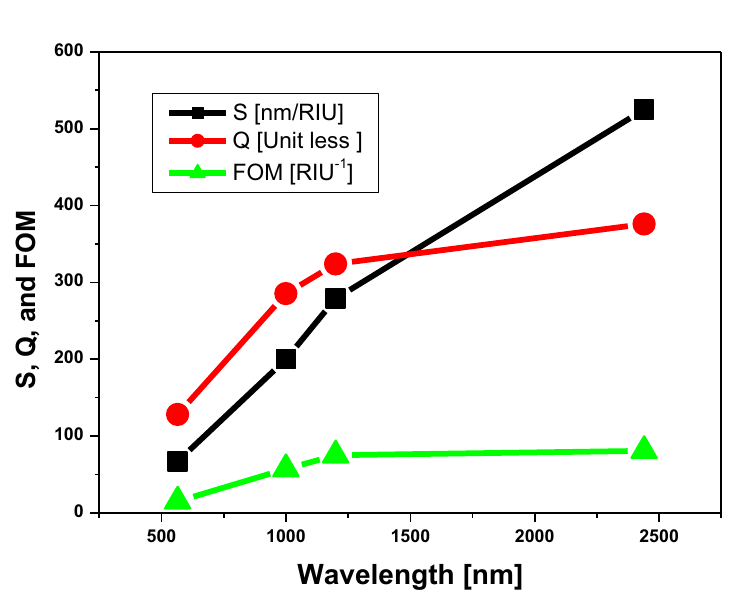
Figure 11. The dependence of sensor parameters on the position of the defect